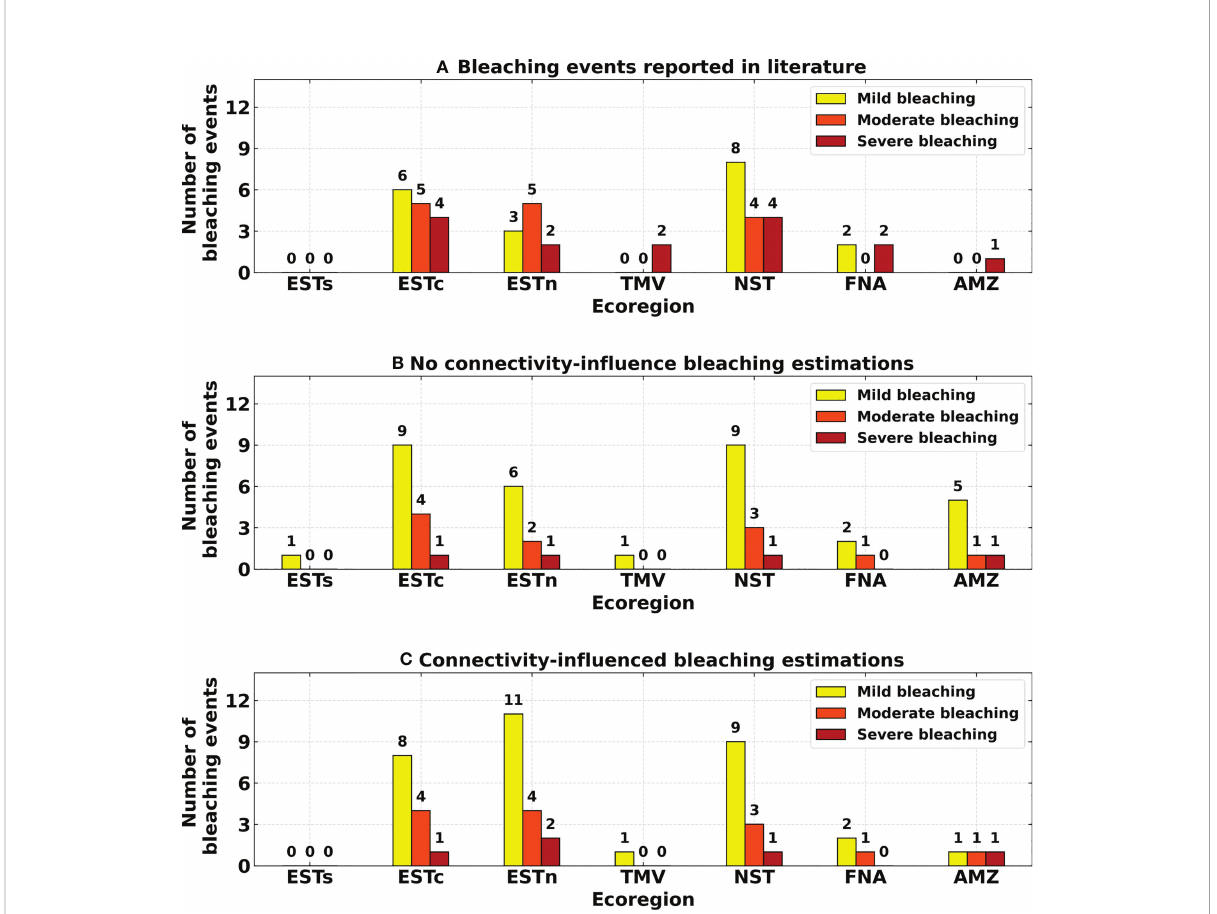
FIGURE 10 Number and severity of bleaching events for each ecoregion: (A) Bleaching events reported in the literature; (B) No connectivity-in fl uence estimated bleaching events; (C) Connectivity-in fl uenced estimated bleaching events. Ecoregions: Eastern-south (ESTs); Eastern-center (ESTc); Eastern-north (ESTn); Northeastern (NST), Amazon (AMZ), Fernando de Noronha-Atol das Rocas (FNA), Trindade-Martim Vaz Islands